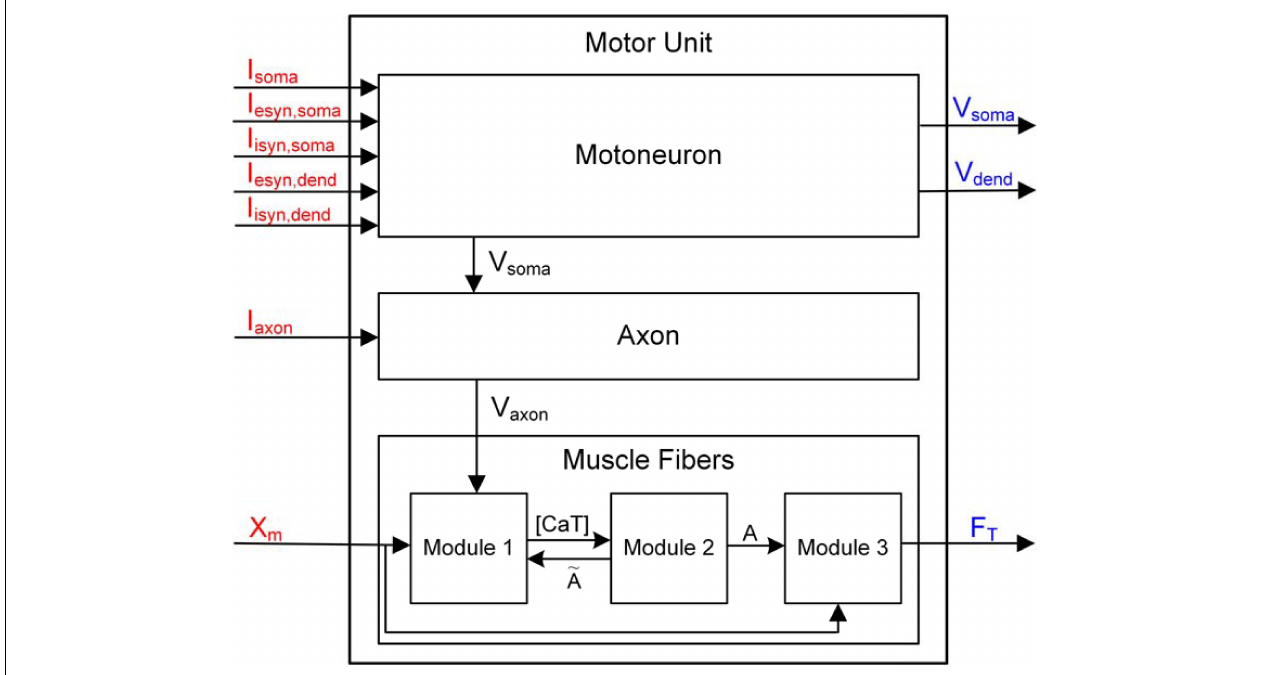
FIGURE 2 | Data flow diagram for PyMUS. Input and output signals considered for the simulation software are indicated in red and blue as represented in Figure 1 . V soma and V axon represent the membrane voltage data flowing from the motoneuron to the axon and from the axon to the muscle fibers, respectively. [CaT], Ã and A in the muscle fibers indicate the concentration of Ca 2 + bound to troponin in the sarcoplasm, muscle activation level for steady and dynamic excitation condition, respectively (see Force Production of Muscle Fibers in “Materials and Methods” for the detailed explanation on the three